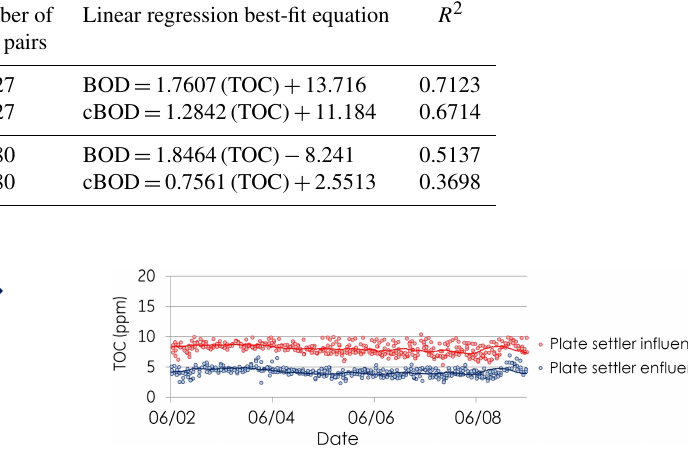
Figure 3. TOC for both streams showing removal from influent to